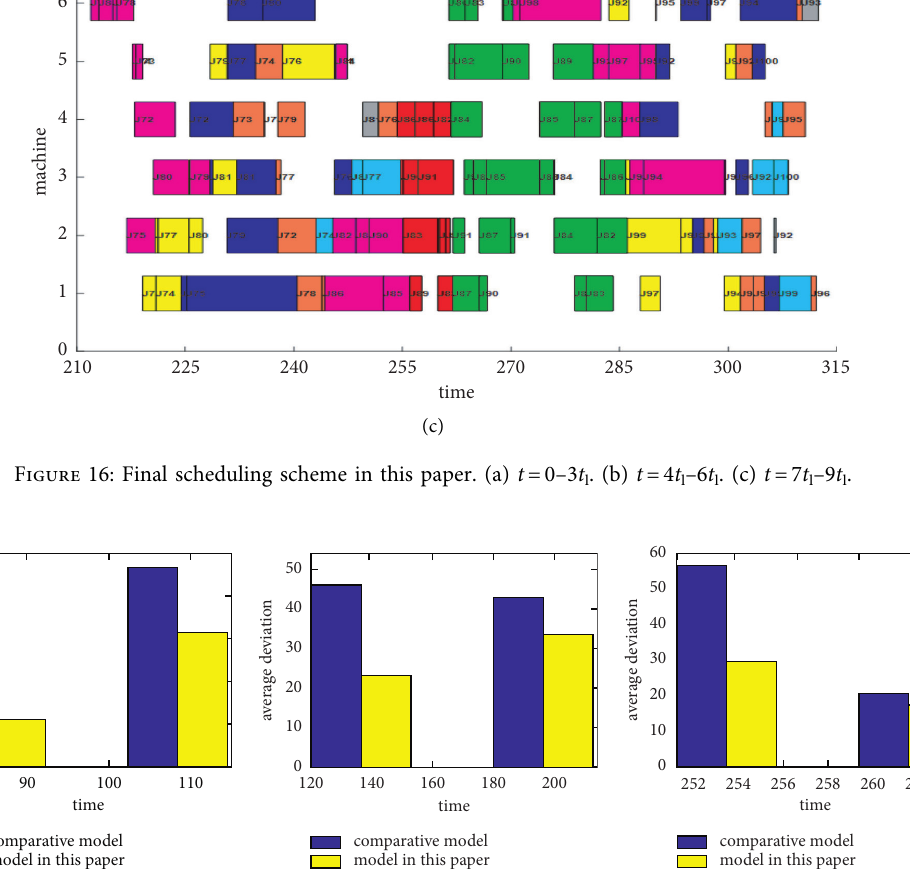
Figure 17: Comparison of deviations between old and new scheduling schemes during machine failure and failure recovery. (a) M2 failure. (b) M5 failure. (c) M6